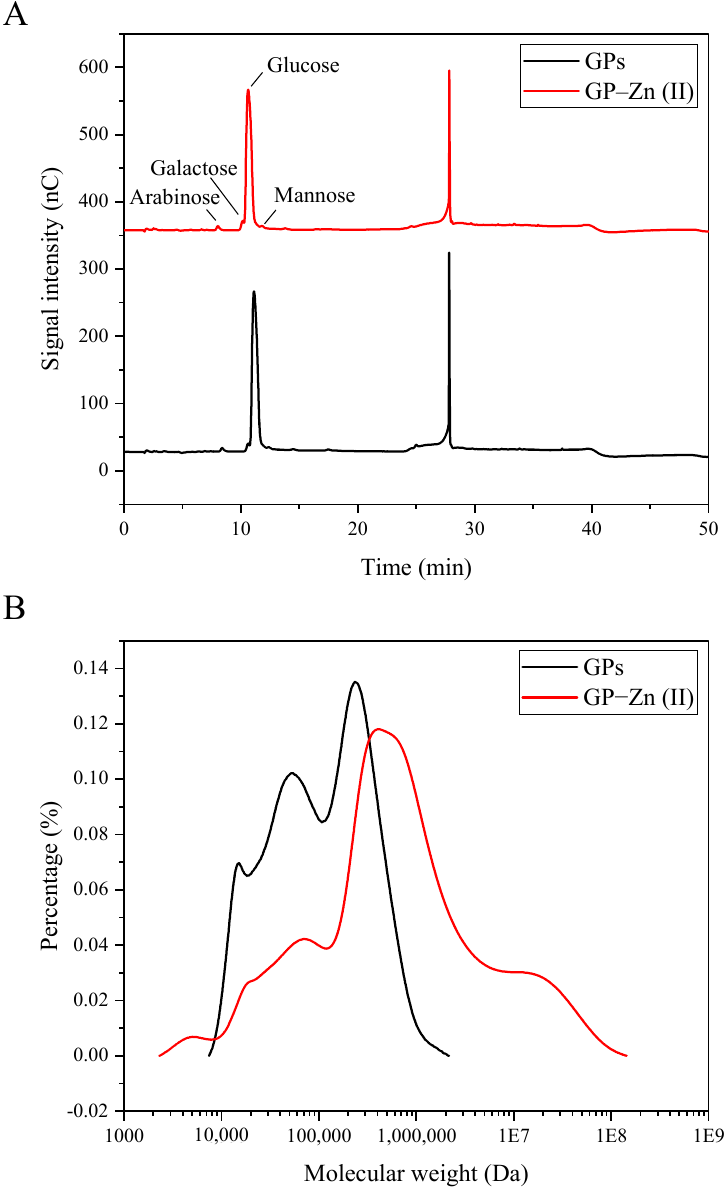
Figure 1. Monosaccharide profile ( A ) and molecular weight distribution ( B ) of ginger peel polysac- charide (GPs) and their Zn (II) derivatives.